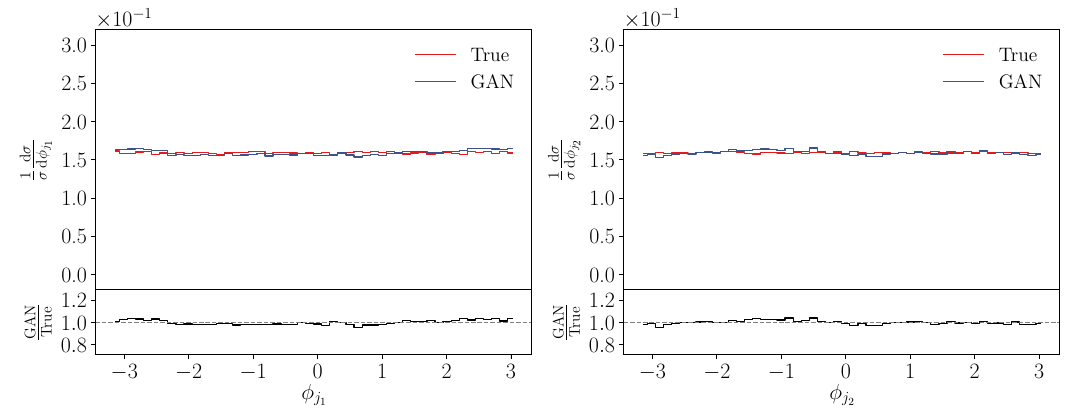
Figure 5: φ distributions of j truth to GAN distribution.